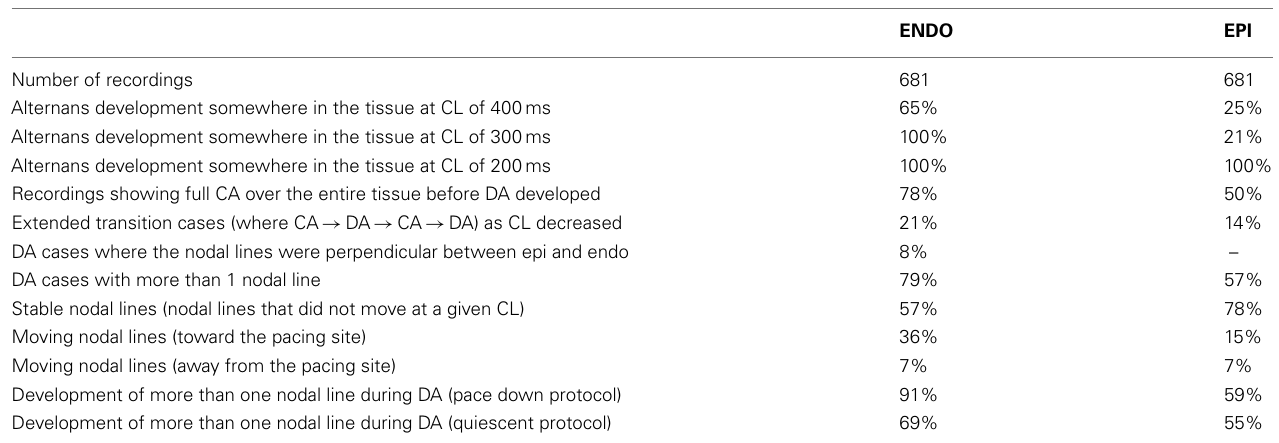
Table 1 | Summary of